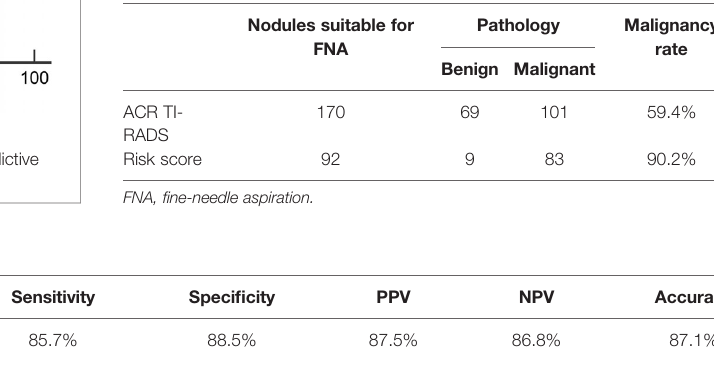
TABLE 9 | Comparing two methods in screening non-hypovascular thyroid nodules for